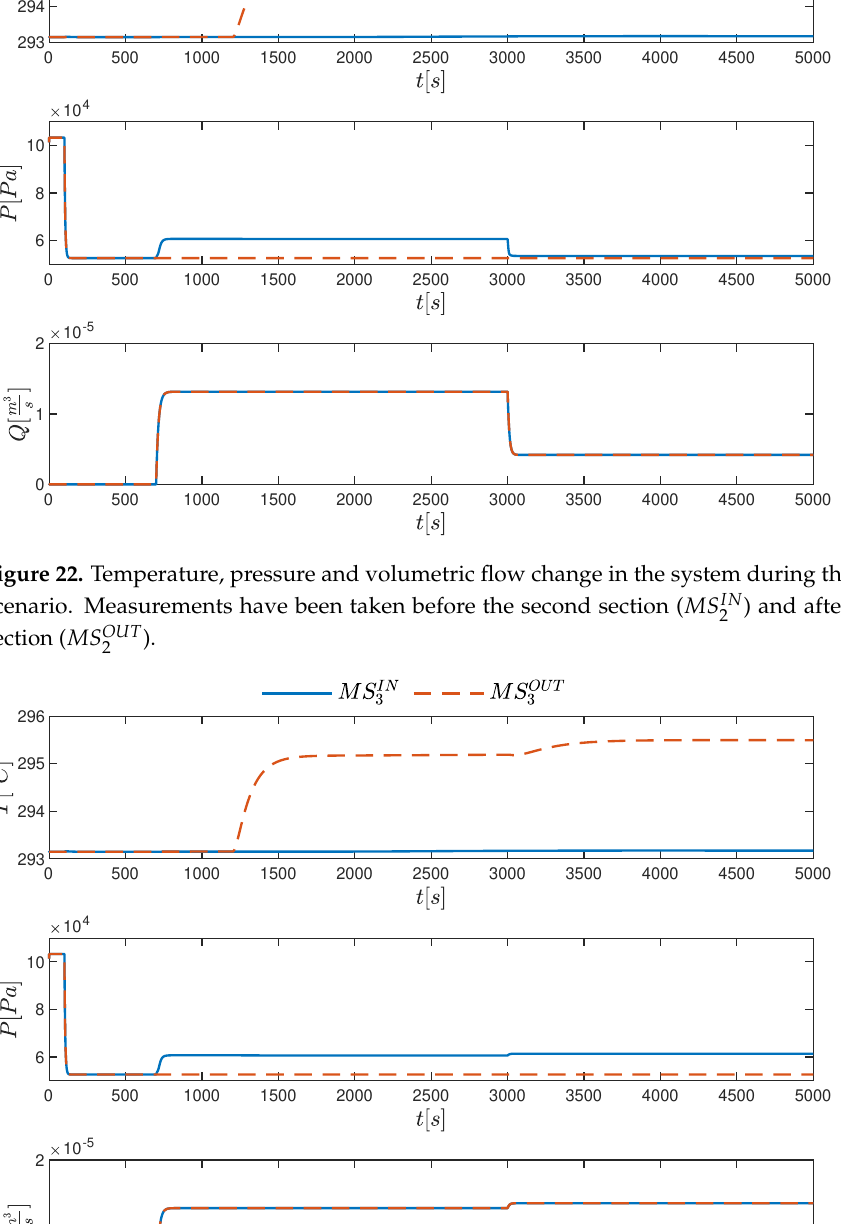
Figure 23. Temperature, pressure and volumetric flow change in the system during the simulation scenario. Measurements have been taken before the third section ( MS IN ( MS OUT 3